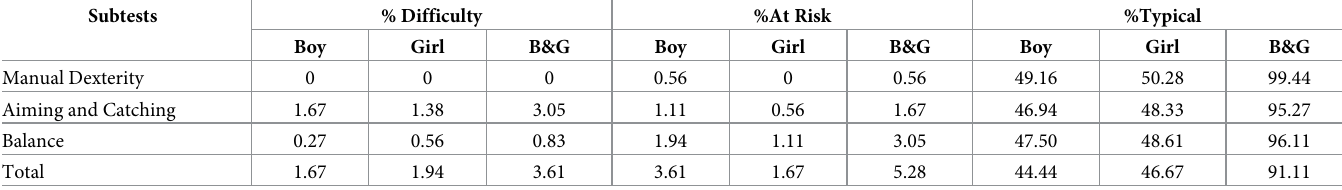
Table 6. Percentages of male and female participants with movement difficulty, movement at risk, and typical movement (n = 360). Subtests Manual Dexterity Aiming and